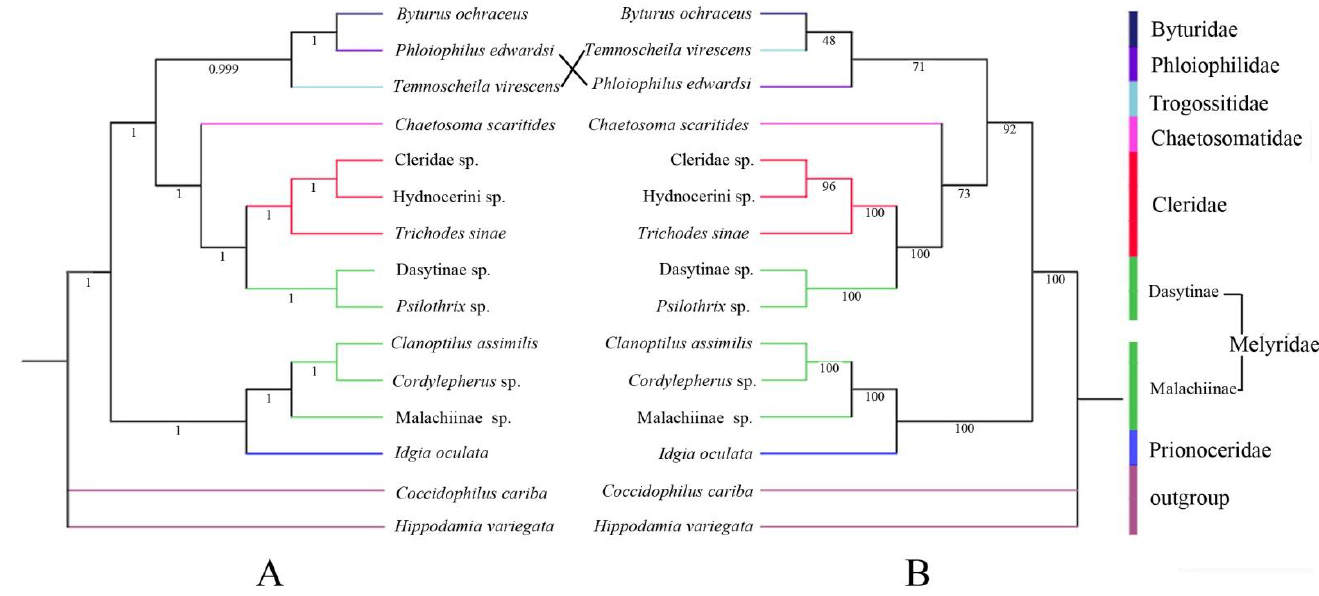
Figure 5. Phylogenetic tree of Cleroidea produced from maximum likelihood (ML) ( A ) and Bayesian inference (BI) ( B ) analyses based on 13 PCGs (posterior probabilities (PP) and bootstrap (BS) values indicated in each clade).